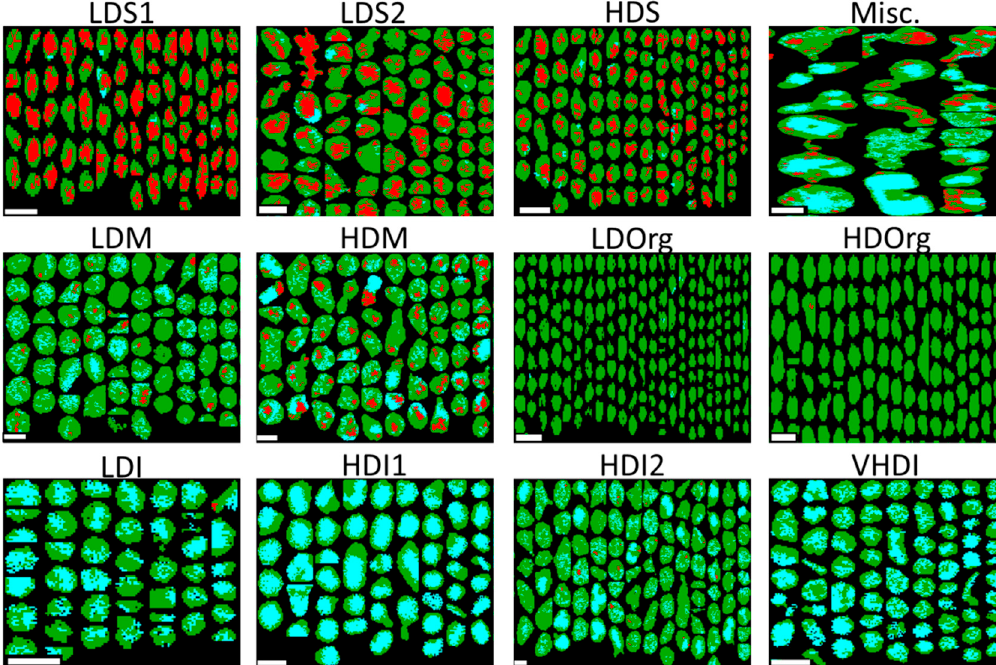
Figure 3. Random sample of ~40 particles from each cluster showing sub-particle carbon speciation as either soot (red), inorganic (teal), or organic (green). 1 µm scale bars are shown in the bottom left of each image. Cluster identification (image labels) is provided in Table 3.